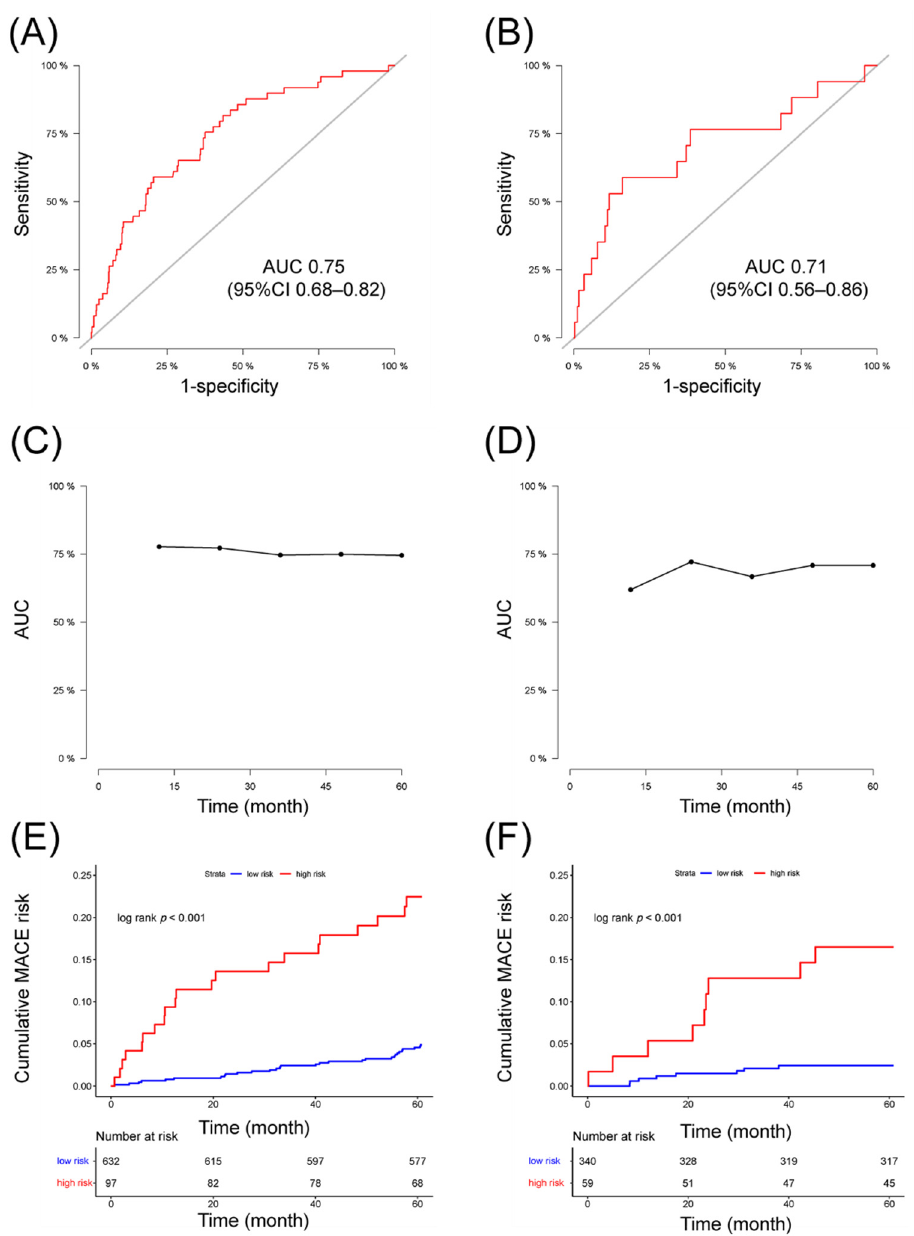
Figure 4. Discrimination of the nomogram in derivation and validation set. Receiver operating characteristic curve of 5-year MACE prediction in derivation set ( A ) and validation set ( B ). The area under curve of the nomogram for predicting 1-year to 5-year MACE in derivation data ( C ) and validation set ( D ). Kaplan–Meier curves of the derivation set ( E ) and validation set ( F ) stratified by prognostic scores. Low risk: prognostic score < 155. High risk: prognostic score ≥ 155.